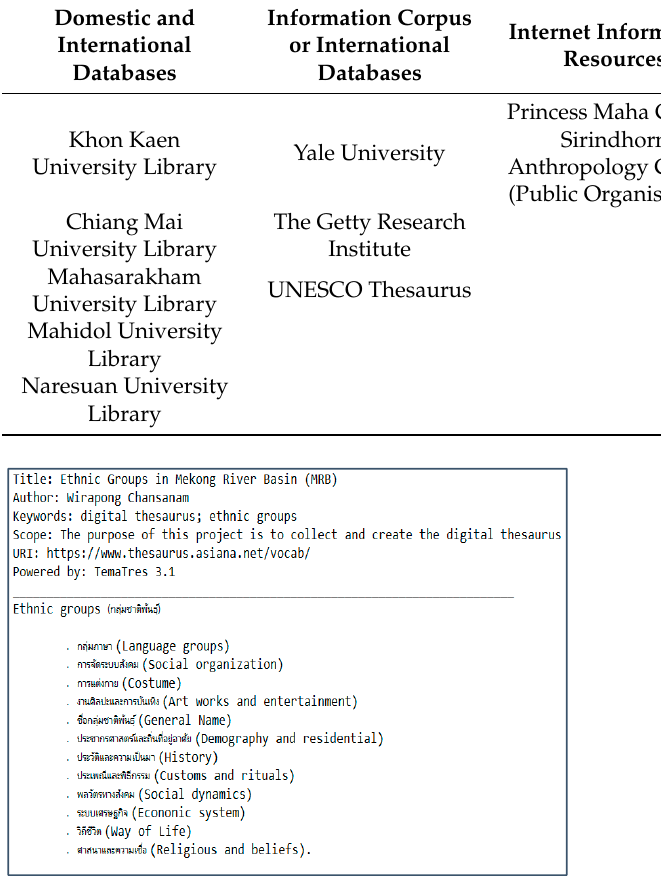
Informatics 2021 , 8 , x Figure 1. Key groups of vocabularies on ethnic groups in the MRB. Figure 1. Key groups of vocabularies on ethnic groups in the MRB.